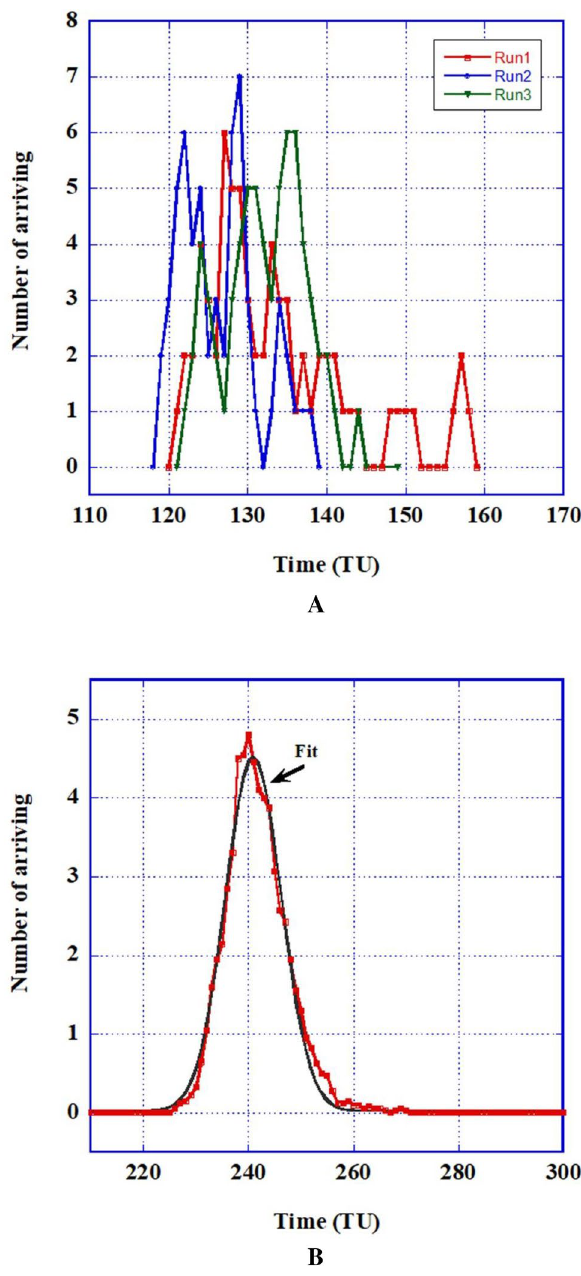
Figure 3. (Colors on line) Output (arriving active cells at the last row) for p = 70%. ( A ) Three individual runs of 100 × 100 matrices with different random distributions of inactive cells. ( B ) Average output of forty 200 × 200 matrices and the Gaussian